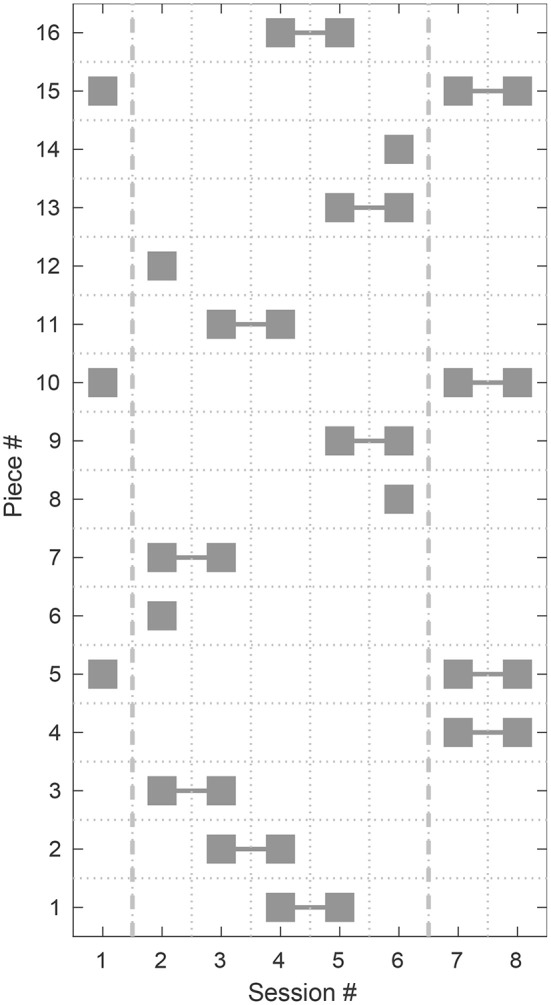
Distribution of the musical stimuli to the particular experimental sessions. The pieces presented in Session 1 were repeated in Sessions 7 and 8 to investigate long term effects. In the Sessions 2 to 6 (between the dashed vertical lines) two pieces from the previous session were repeated and two new pieces were presented in each session.